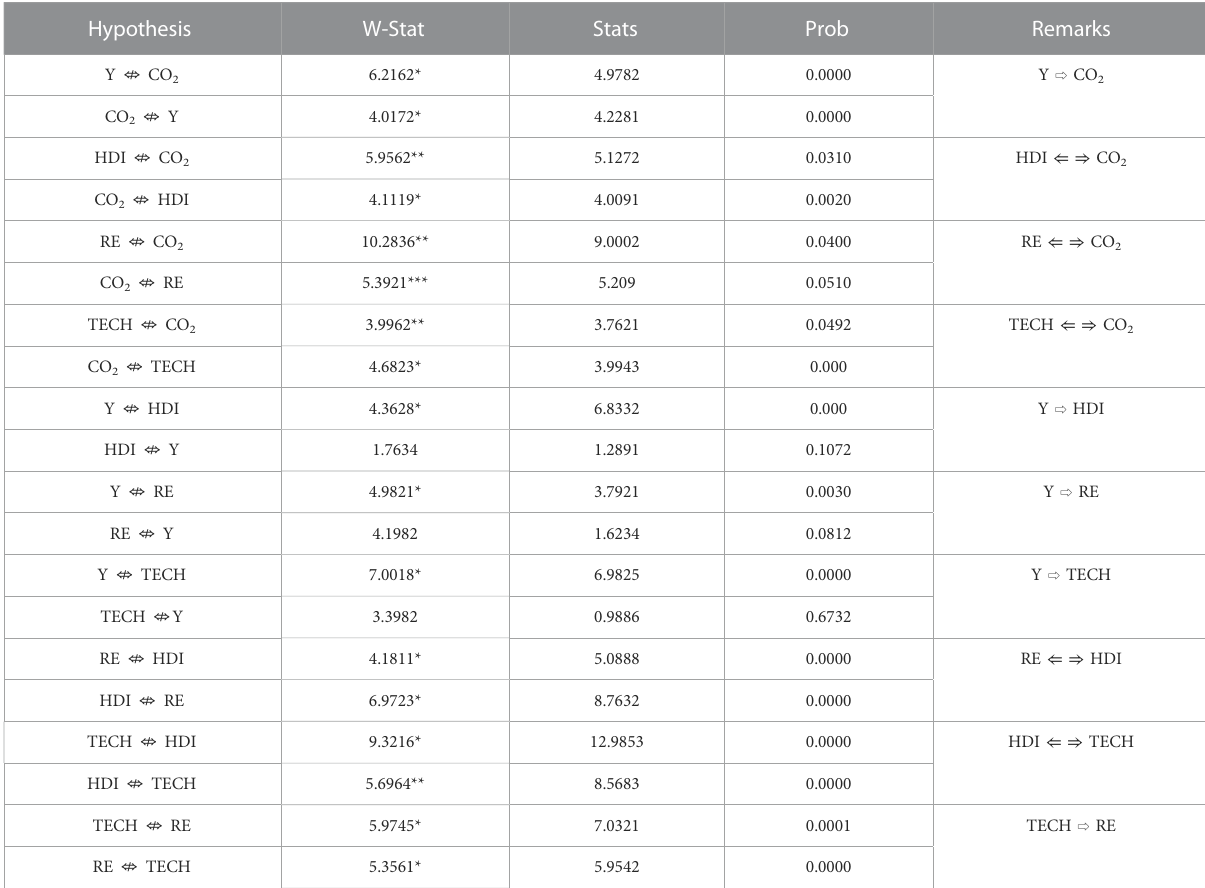
TABLE 9 Findings of D-H causality test.